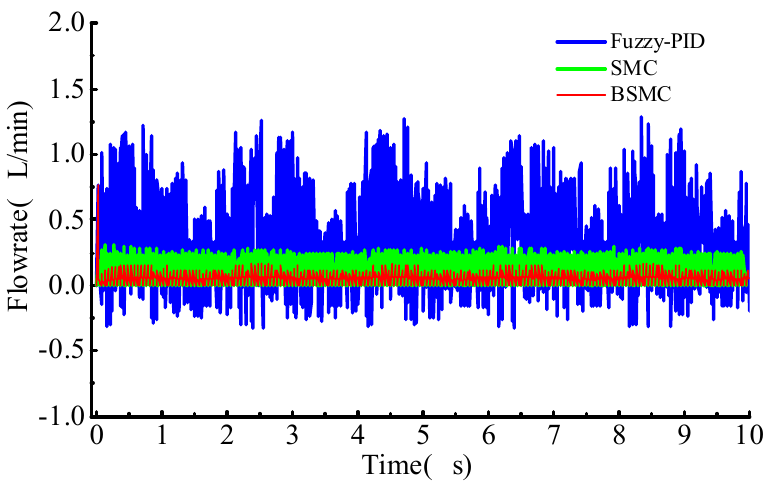
Figure 4. Outlet flow of the pump under random load.